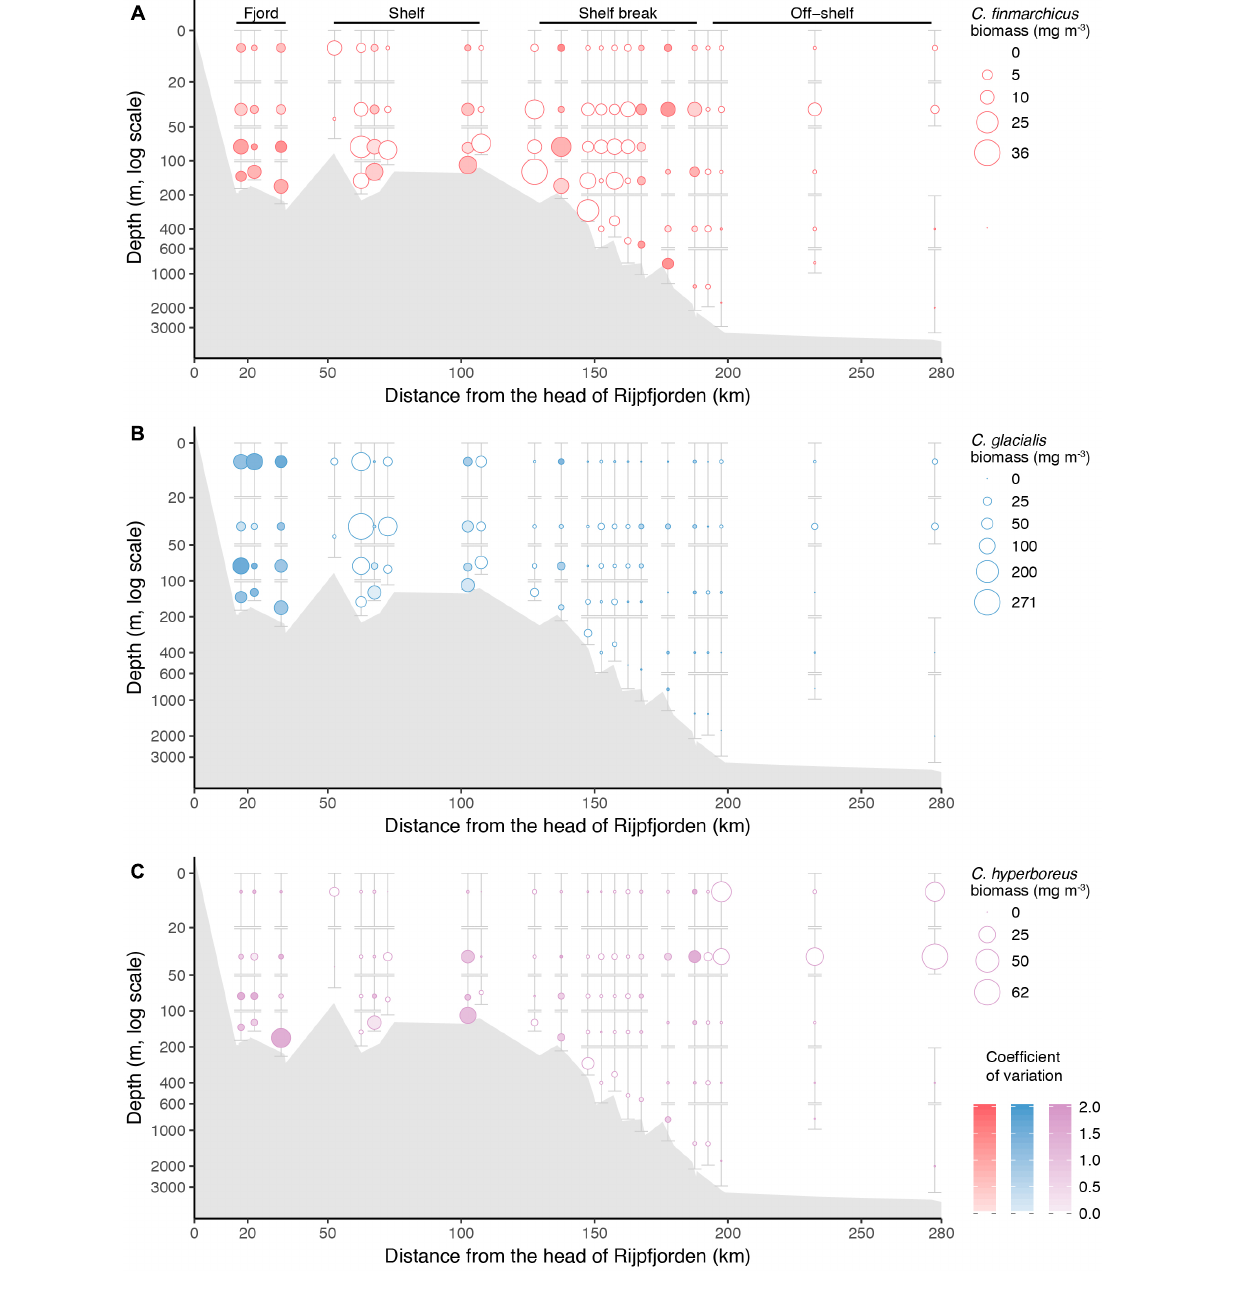
associated with grazing by populations of larval fish and other pelagic zooplanktivorous grazers (e.g., jellyfish and amphipods) following the AW flow (Basedow et al., 2018). The zooplankton their prey, as well as mesopelagic concentrations of fish and along the northern continental shelf (Ingvaldsen et al.,